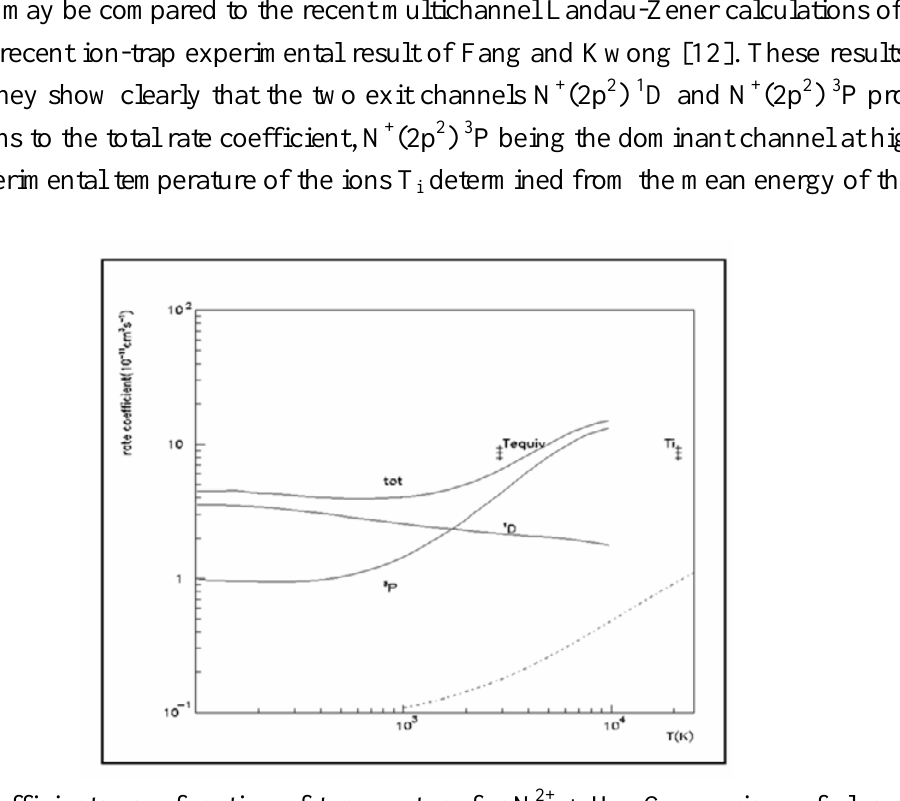
Fig. 2 : Rate coefficients as a function of temperature for N 2+ + He. Comparison of close-coupling calculations [21] (full curves) and multichannel Landau-Zener approach [20] (dotted-broken curve) and T with ion-trap experiment at T i equiv